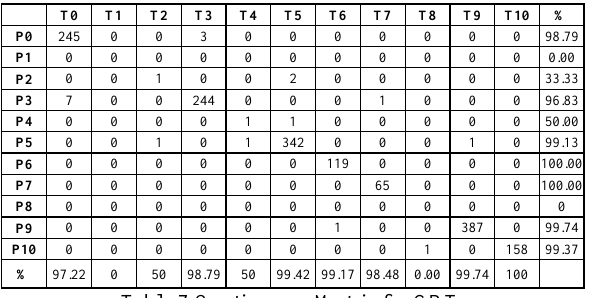
Table 7 Contingency Matrix for